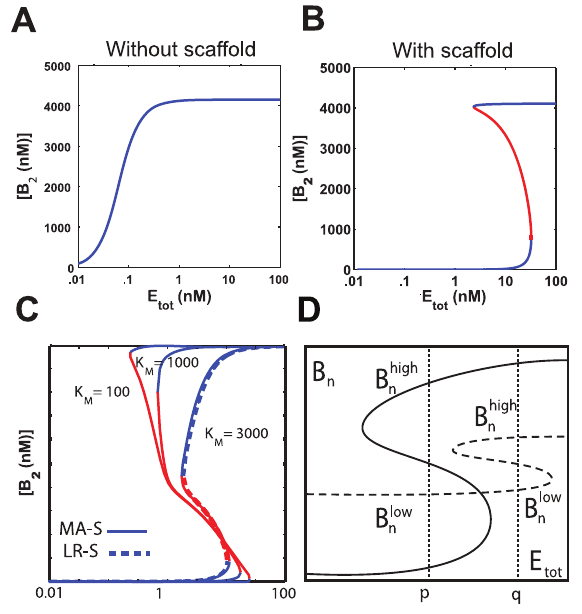
Figure 4. Dose responses and bistability. A) Dose response curve without scaffold binding (MA-NS) exhibits one steady state for any given input. B) The full model MA-S with scaffold binding, using the same parameter set and additional scaffold parameters, exhibits multiple steady states for certain inputs. See Table S1 for parameter values. C) Comparison of LR-S and MA-S models. The dashed curve represents the dose response for LR-S, and the solid curves the dose response of MA-S for corresponding parameters and increasing K M values. See Table S2 for parameter values. D) Comparison of the fold ratio of steady states for two hypothetical dose response curves. For the = B low for the input E tot ~ q is relatively dotted line, the ratio r ~ B high n n small compared to the fold ratio r of the solid line for E tot ~ p .